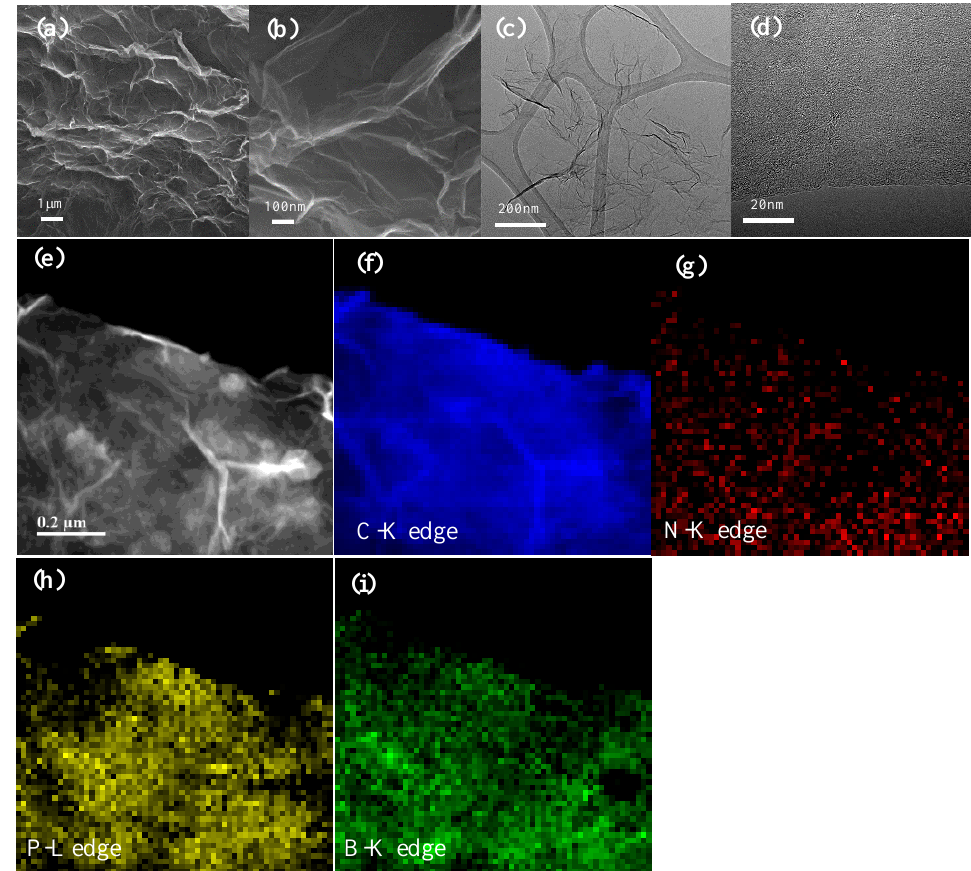
Figure 1. SEM ( a , b ) and TEM ( c , d ) images of ternary doped RGO using two-step method. Note that the sheet-like graphenes are corrugated and wrinkled. ( e ) Elastic TEM image and EELS elemental mapping images of ( f ) carbon, ( g ) nitrogen, ( h ) phosphorous, and ( i ) boron atoms.